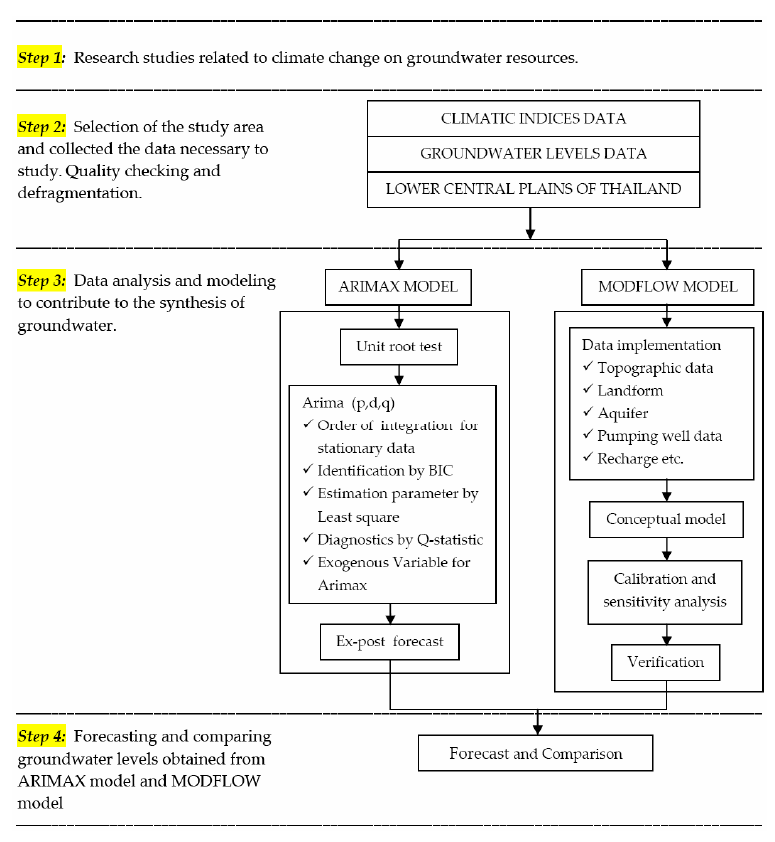
Figure 3. Methodological process for obtaining groundwater levels.